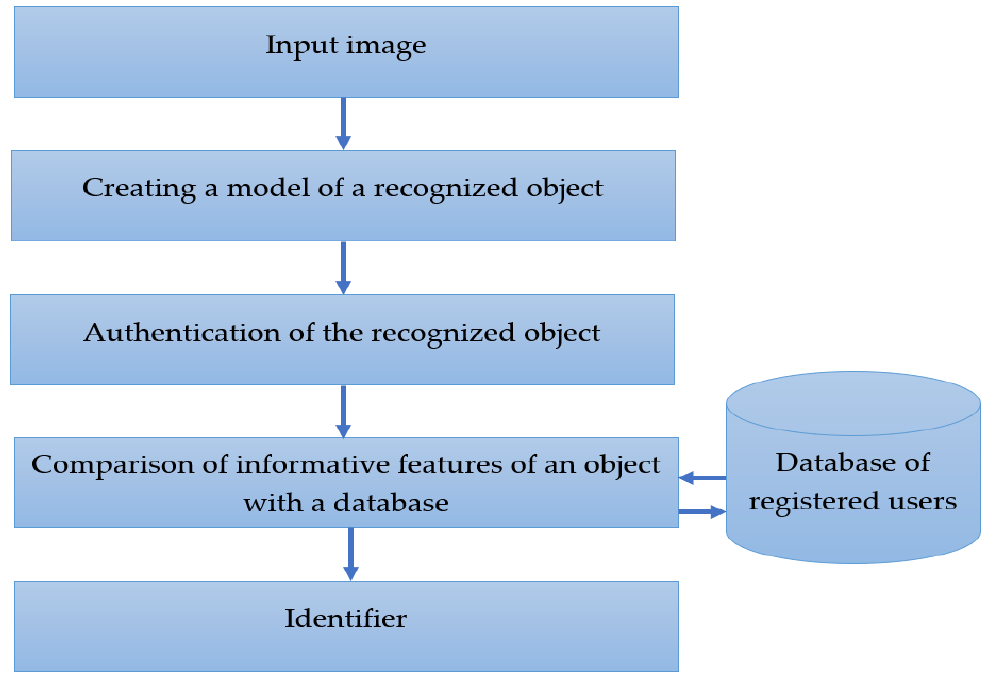
Figure 1. Structure of the face image recognition